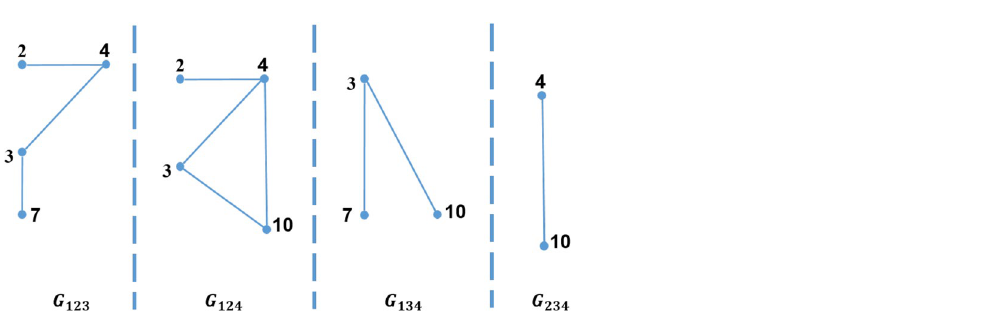
Figure 7. 3-partition of the graph in Fig. 2 using